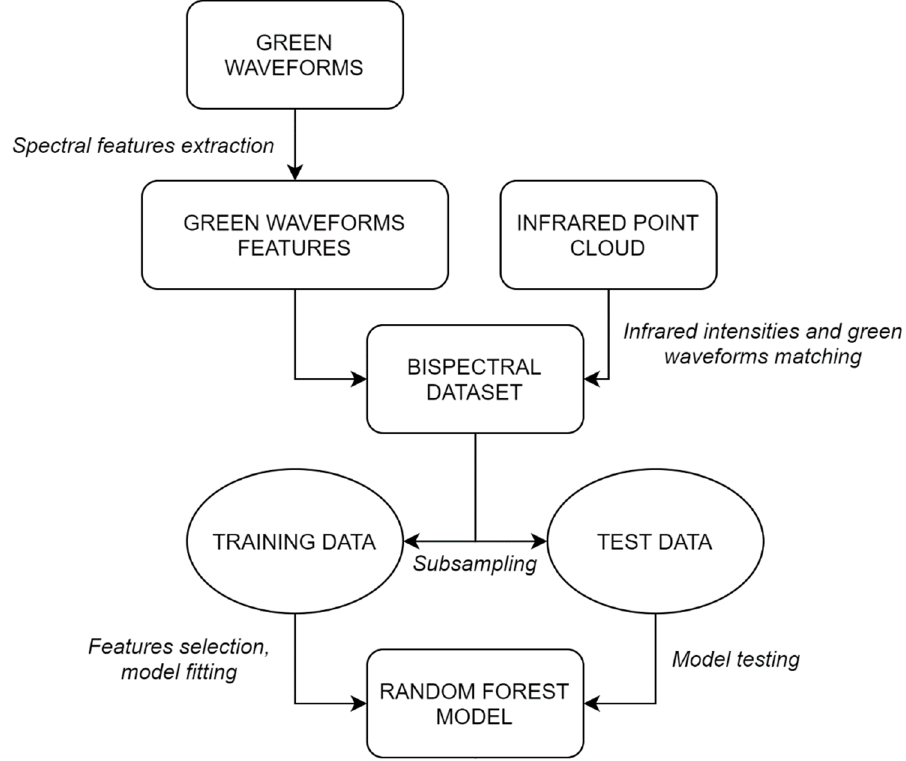
Figure 6. Flowchart of the overall methodology.